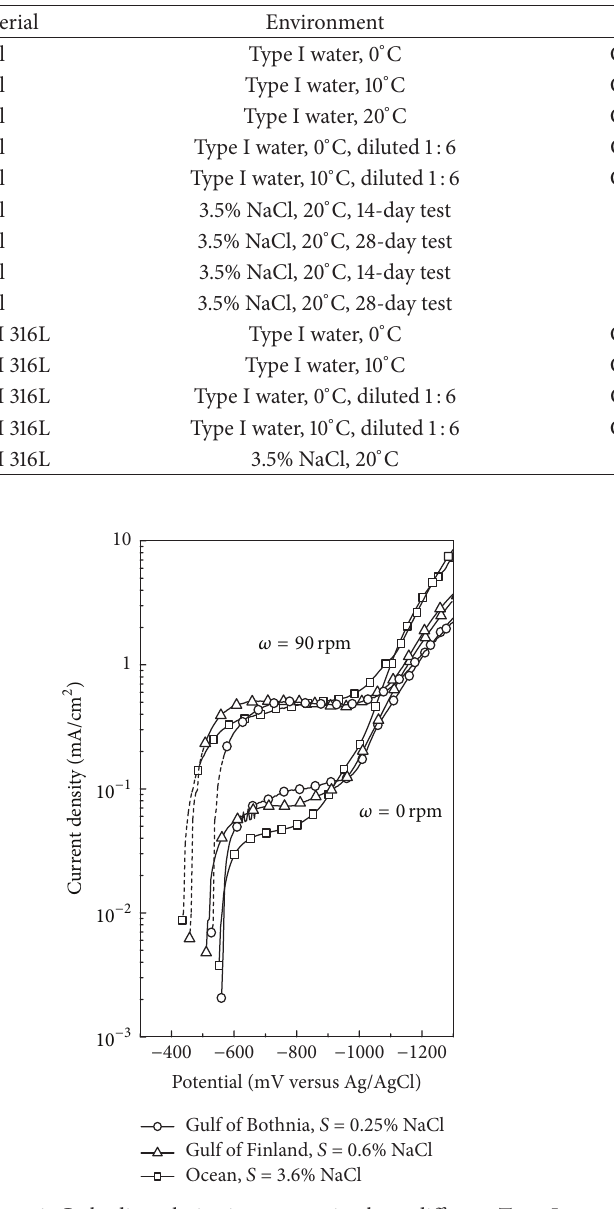
Figure 6: Cathodic polarization curves in three different Type I synthetic seawater samples of different salinity.